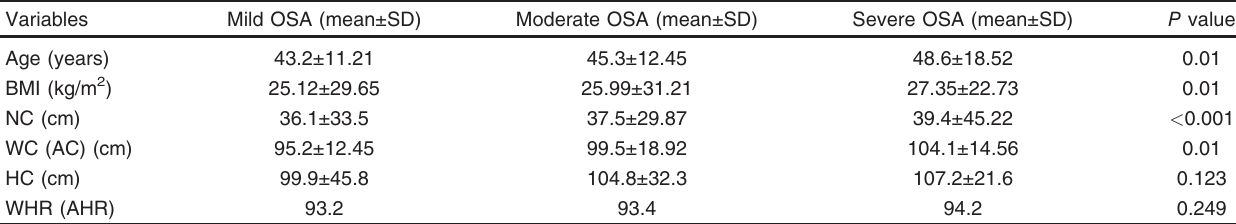
Table 4 Comparison between anthropometric indices and obstructive sleep apnea severity